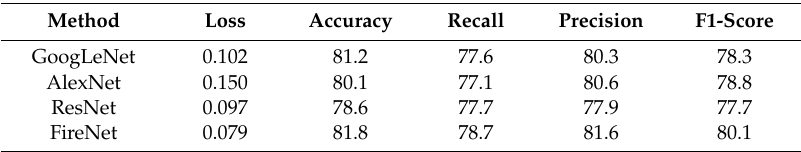
Table 3. Results before using NPSO method in comparison with standard convolutional neural networks (CNN)